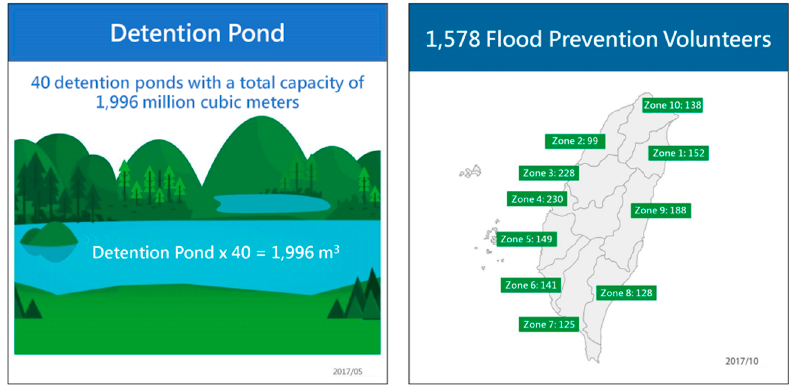
Figure 7. Information Visualization.